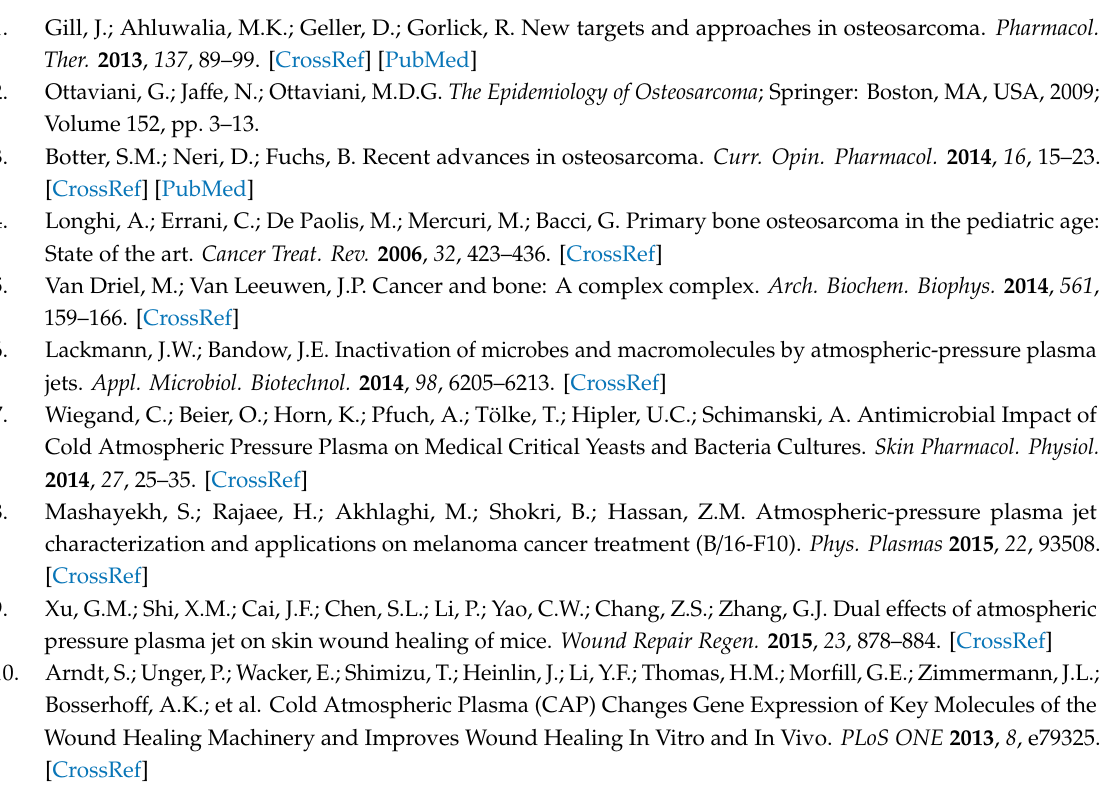
Figure S1: Time stability of H 2 O 2 and NO 2 − produced; Figure S2: E ff ects on cell death by PAR treatment time in MG-63 cells and hBM-MSCs; Figure S3: Generation of NO 2 − and H 2 O 2 by APPJ at the corresponding conditions for cell culture and organotypic protocols, Figure S4. Caspase-3 immunostaining in mouse tumor